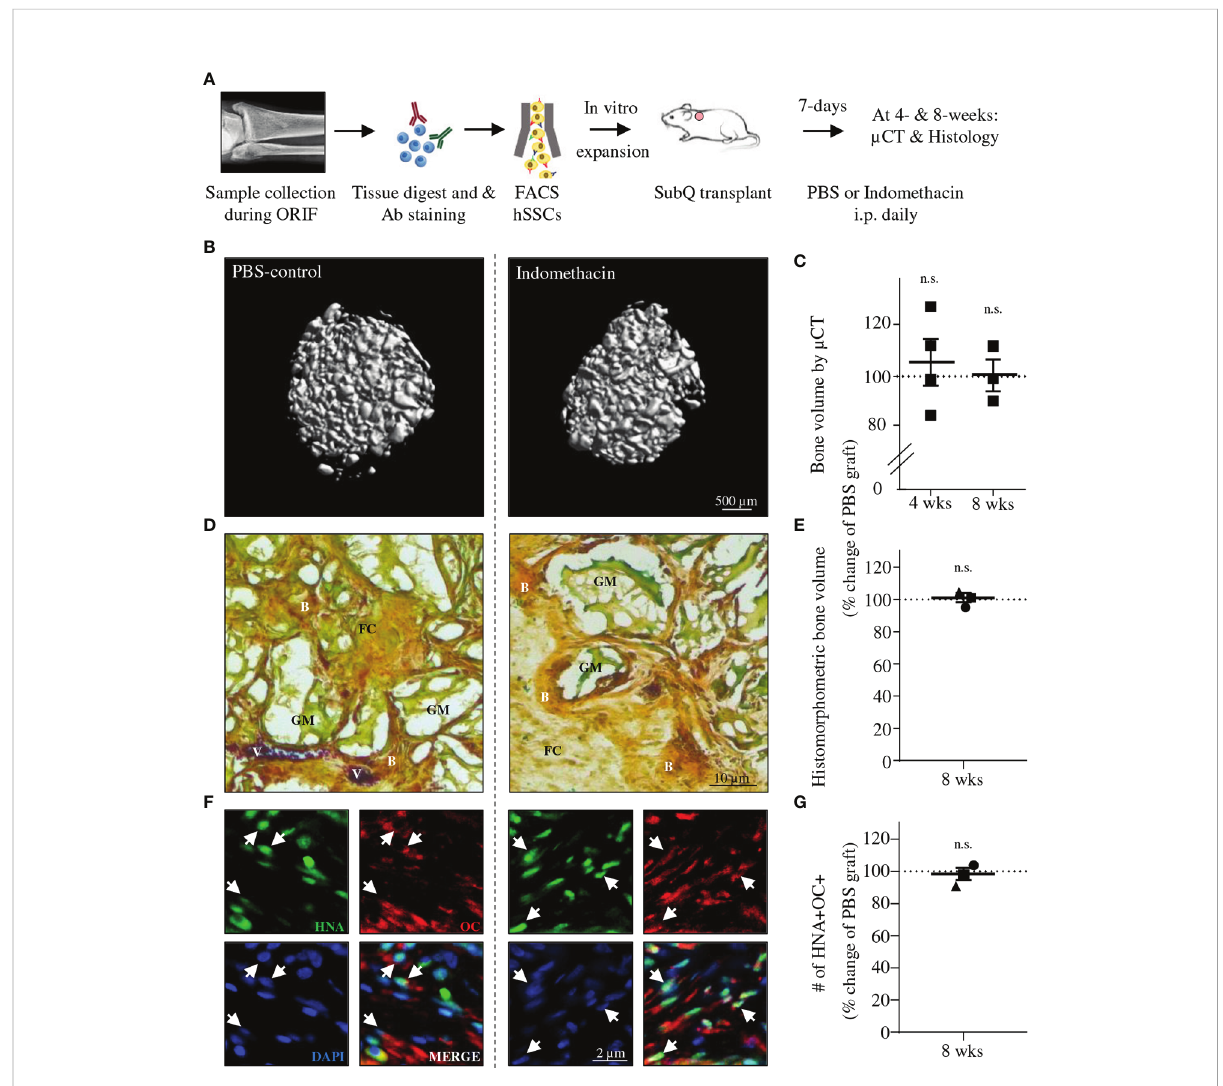
FIGURE 4 Indomethacin does not interfere with in vivo ossicle formation of human SSCs. (A) Experimental schematic for in vivo grafting of hSSCs and treatment of mice with Indomethacin. (B) Three-dimensional microCT reconstruction of mineralized graft tissue. (C) Quanti fi cation of mineralized graft tissues (total bone volume) at 4- (n=4) and 8-weeks (wks; n=3) post transplant between PBS and Indomethacin treated mice. Results from seven experiments with hSSCs from distinct patients. (D) Representative Movat Pentachrome staining of sectioned grafts (B, Bone; FC, Fibrocartilage; V, Blood vessel; GM, Graft material). (E) Histomorphometric quanti fi cation of graft bone volume (each data point represents average of three non-adjacent sections per patient hSSC-derived graft). (F) Immunohistochemistry showing graft derived osteogenic cells are of human origin. Human Nuclear Antigen (HNA; green), Osteocalcin (OCN; red), DAPI (blue). (G) Quanti fi cation of OCN-expressing cells of human origin based on IHC. Data shown as mean + SEM. Statistical testing by paired Student ’ s t-test (n.s., not signi fi